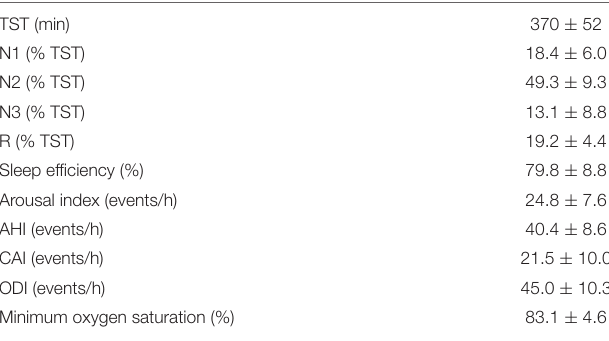
TABLE 1 | Polysomnographic data of studied patients ( N =